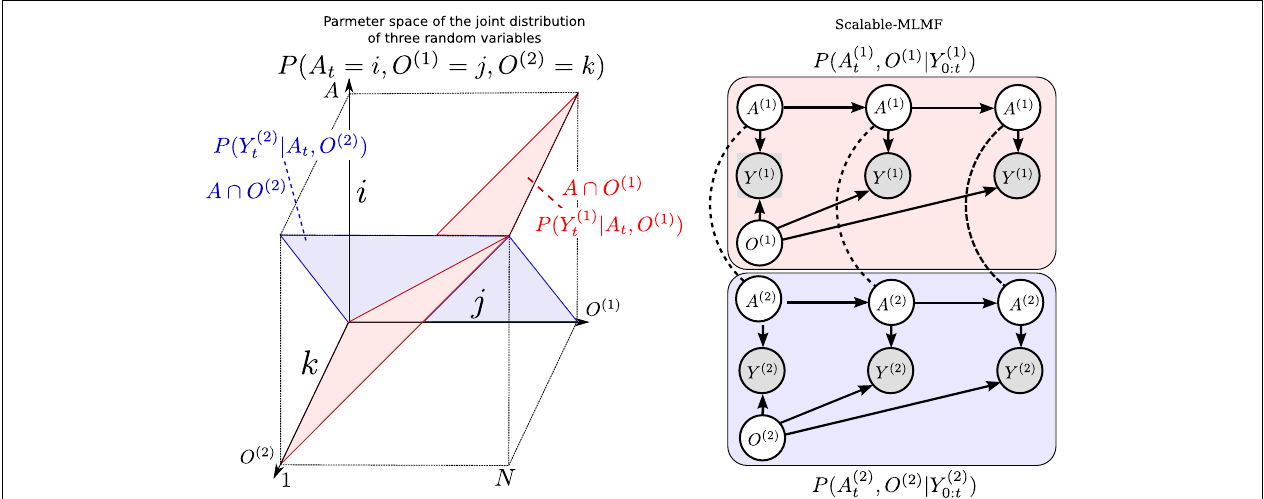
FIGURE 8 | Left : Joint distribution. P ( A , O (1) , O (2) ) of the agent and two objects ( Y 0: t and u 1: t omitted). Each likelihood function, P ( Y|A , O (1) ), P ( Y|A , O (2) ) corresponds to a hyperplane in the joint distribution The state space is discretized to N bins giving a potential total of N 3 parameters for the joint distribution (Histogram case). Right: Scalable-MLMF. Each agent–object joint distribution pair is modeled independently. For clarity, we have left out the action random variable u that is linked to every agent node. Two joint distributions P ( A ( 1 ) , O ( 1 ) | Y ( 1 ) 0: t ) and P ( A ( 2 ) , O ( 2 ) | Y ( 2 ) 0: t ) parametrize the graphical model. The dashed undirected lines represent a wanted dependency, if present O (1) and O (2) are to be dependent through A . In the standard setting, there will be no exchange of information between the individual joint distributions. However, we demonstrate later on how we perform a one-time transfer of information when one of the objects is sensed.